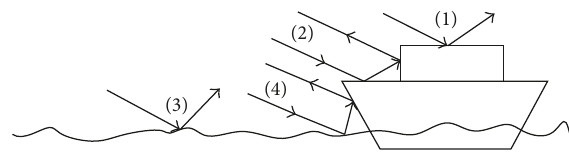
Figure 1: Illustration of composite scattering model.